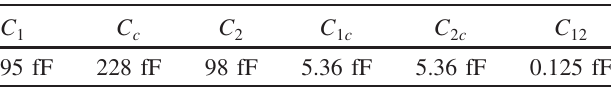
TABLE VI. The capacitances used for the numerical simula- tions (see Ref. [13] for the notations).